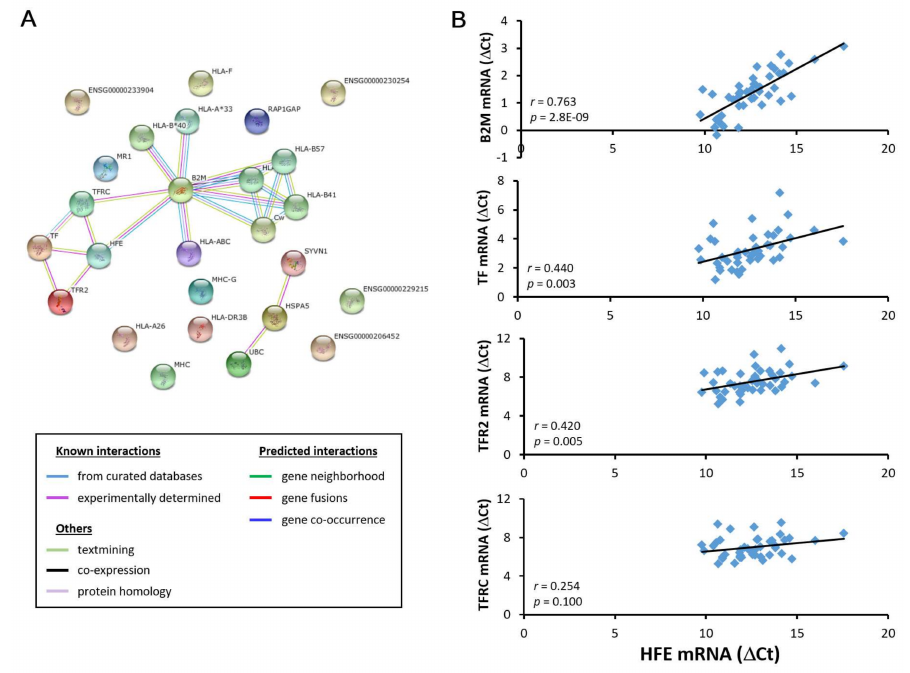
Figure 5. Correlation analysis of HFE and its related molecules in liver grafts from transplant recipients. ( A ) Bioinformatics analysis revealed B2M , TF , TFR2 and TFRC as HFE -related molecules; ( B ) Among these molecules, B2M , TF and TFR2 , but not TFRC , demonstrated a positive gene expression correlation with HFE in liver grafts from 43 transplant recipients using RT-qPCR.